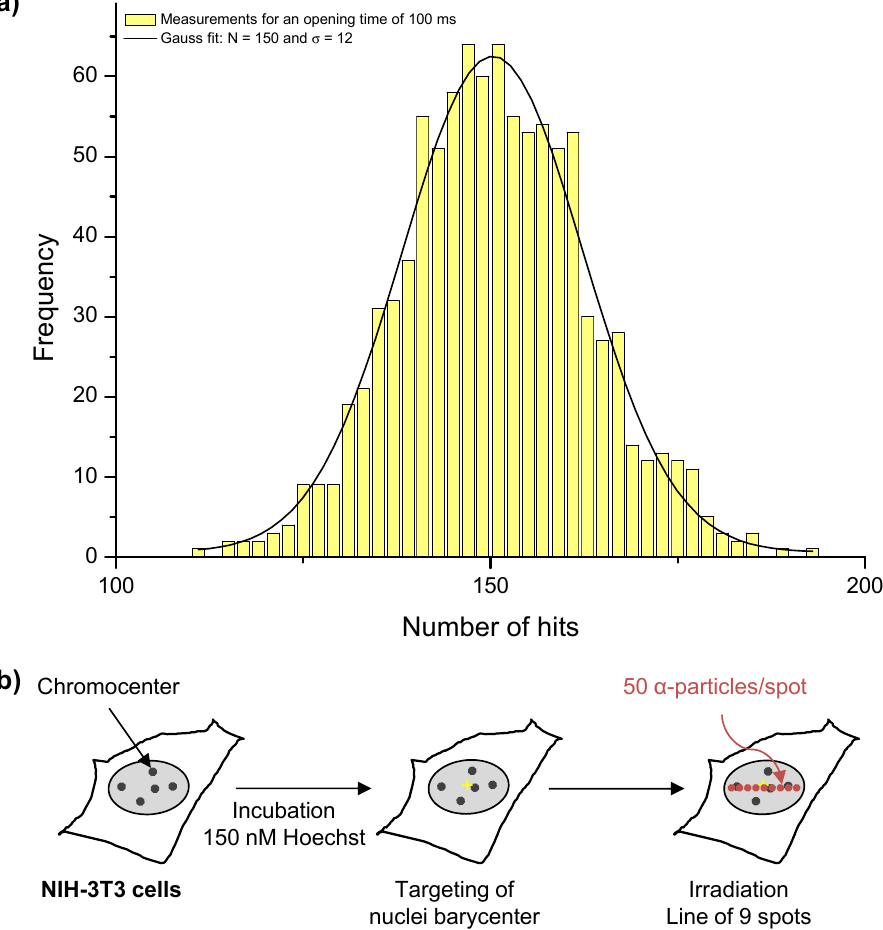
Figure 1. Targeted irradiation on the MIRCOM facility. ( a ) Hit number distribution, used to monitor the mean counting rate of the microbeam between each irradiation. In this example, we performed 961 measurements with a beam opening time of 100 ms. The mean number of ions is 150, with a stan- dard deviation σ = 12, and the relative fluctuation in the delivered hits is thus 8%. ( b ) Experimental scheme for targeted irradiation in a dotted line pattern. We centered within the cell nucleus a pattern of 9 spots spread across an 8 µ m-wide horizontal line and we carried out irradiation by delivering a mean number of 50 ± 7 α -particles on each spot, resulting in a relative fluctuation of